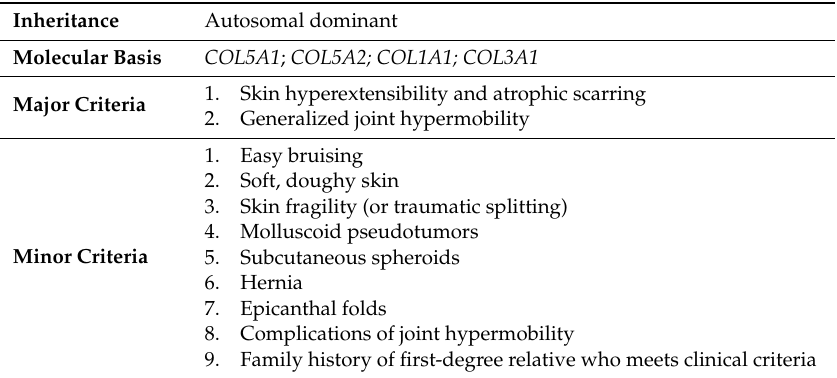
Table 1. Classification of human classical Ehlers–Danlos syndrome